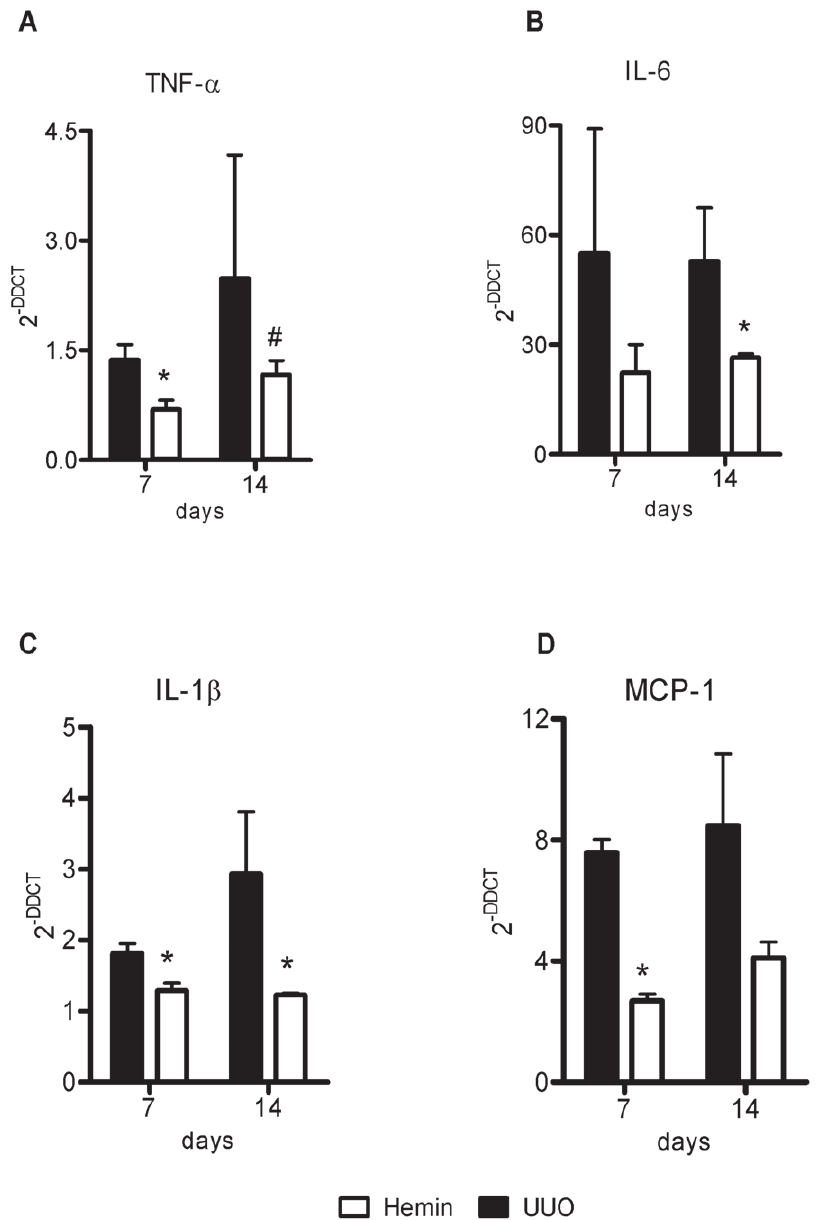
Figure 4. Effects of HO-1 upregulation on inflammatory molecule gene expression after unilateral ureter obstruction. Kidney samples from obstructed kidneys of UUO and Hemin-treated animals were processed and RT-PCR performed for TNF- a (panel A), IL-6 (panel B), IL-1 b (panel C), and MCP-1 (panel D). Kidney tissue from normal rats was used as a control, and assigned a value of 1.Data are shown as average 6 s.e.m. * p , 0,05 vs. UUO and # p , 0,05 vs. Hemin 7